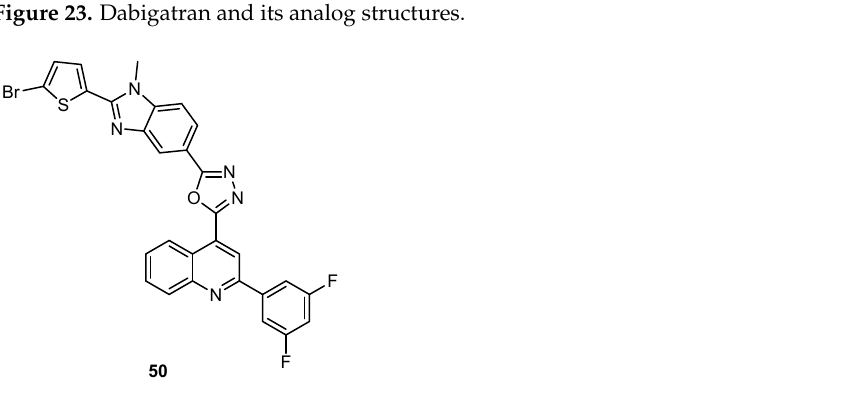
Figure 24. Quinolinyl oxadiazole benzimidazole derivative.